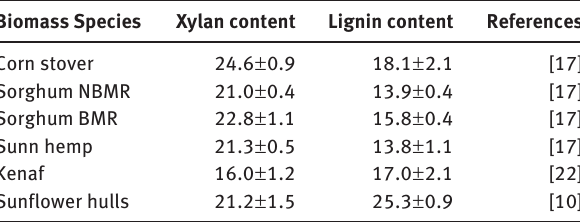
BMR, brown midrib; NBMR, non brown